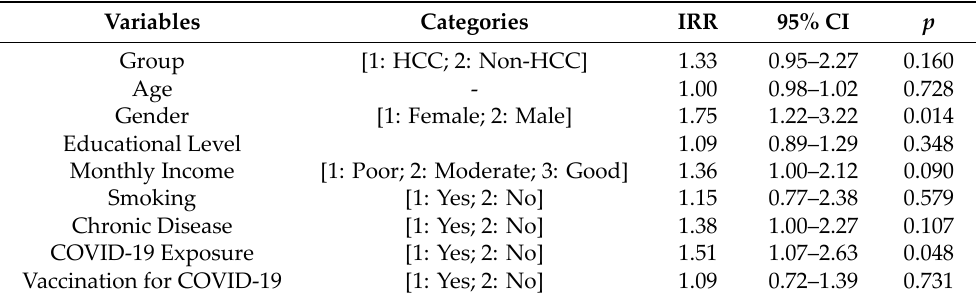
Table 7. Results of the negative binomial regression model for CAS‑SF.